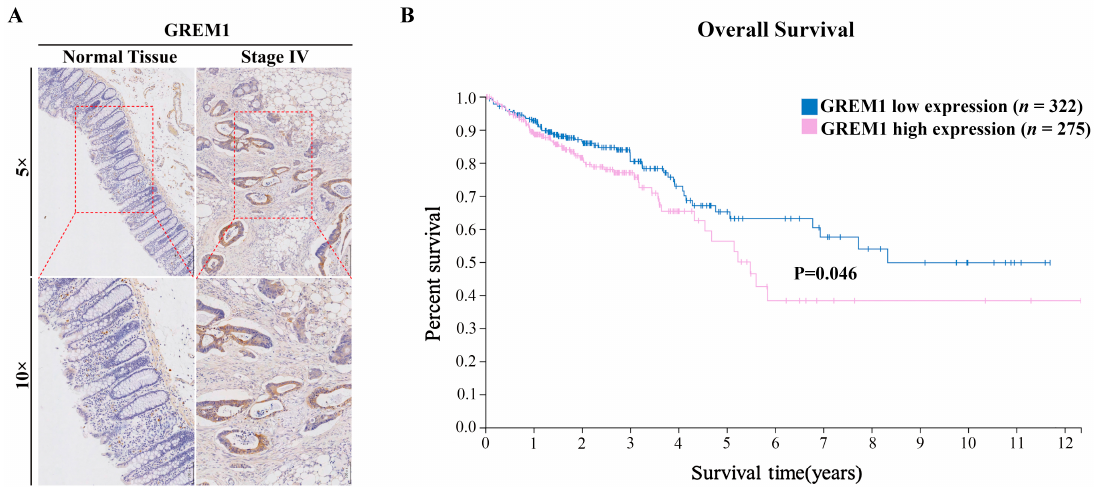
Figure 1. GREM1 expression is correlated with poor survival in CRC patients. ( A ) Representative images of GREM1 in para-carcinoma and carcinoma tissues of patients with stage IV CRC. Scale bar, 250 µ m. ( B ) Kaplan–Meier survival analysis of 597 colon cancer patients stratified by GREM1 expression levels. Kaplan–Meier survival analysis and GREM1 mRNA expression according to FPKM value 5.31 as a cutoff value in the whole cohort. p = 0.046 by log-rank (Mantel–Cox)